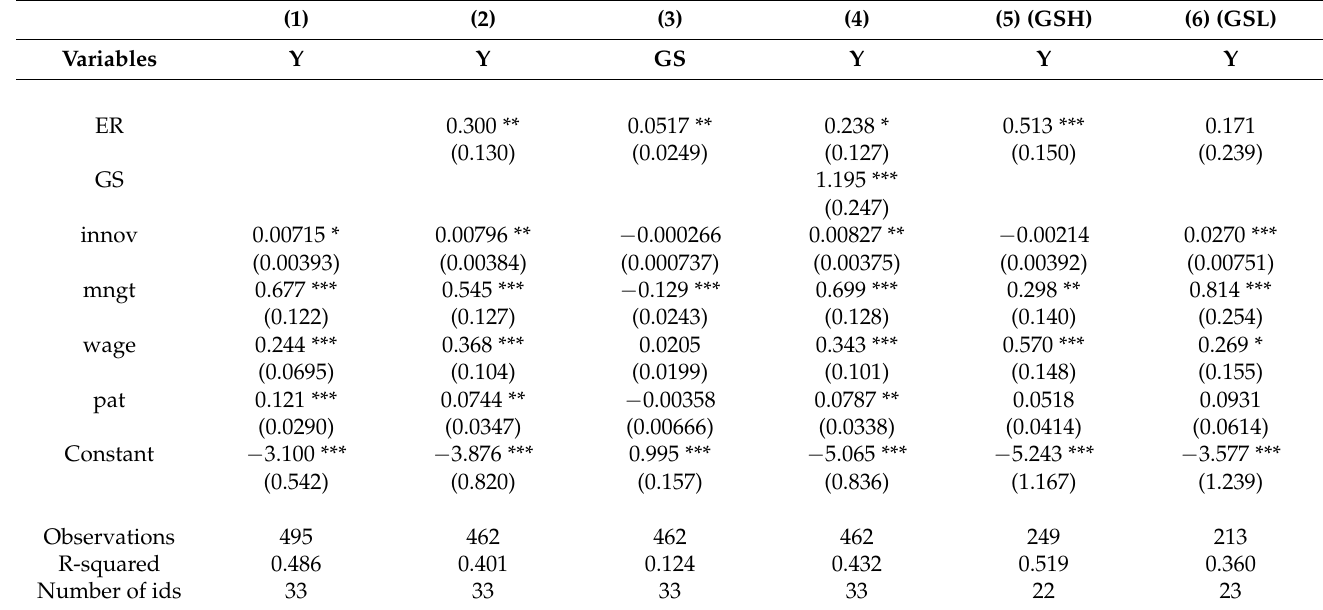
Table 3. Model estimation and